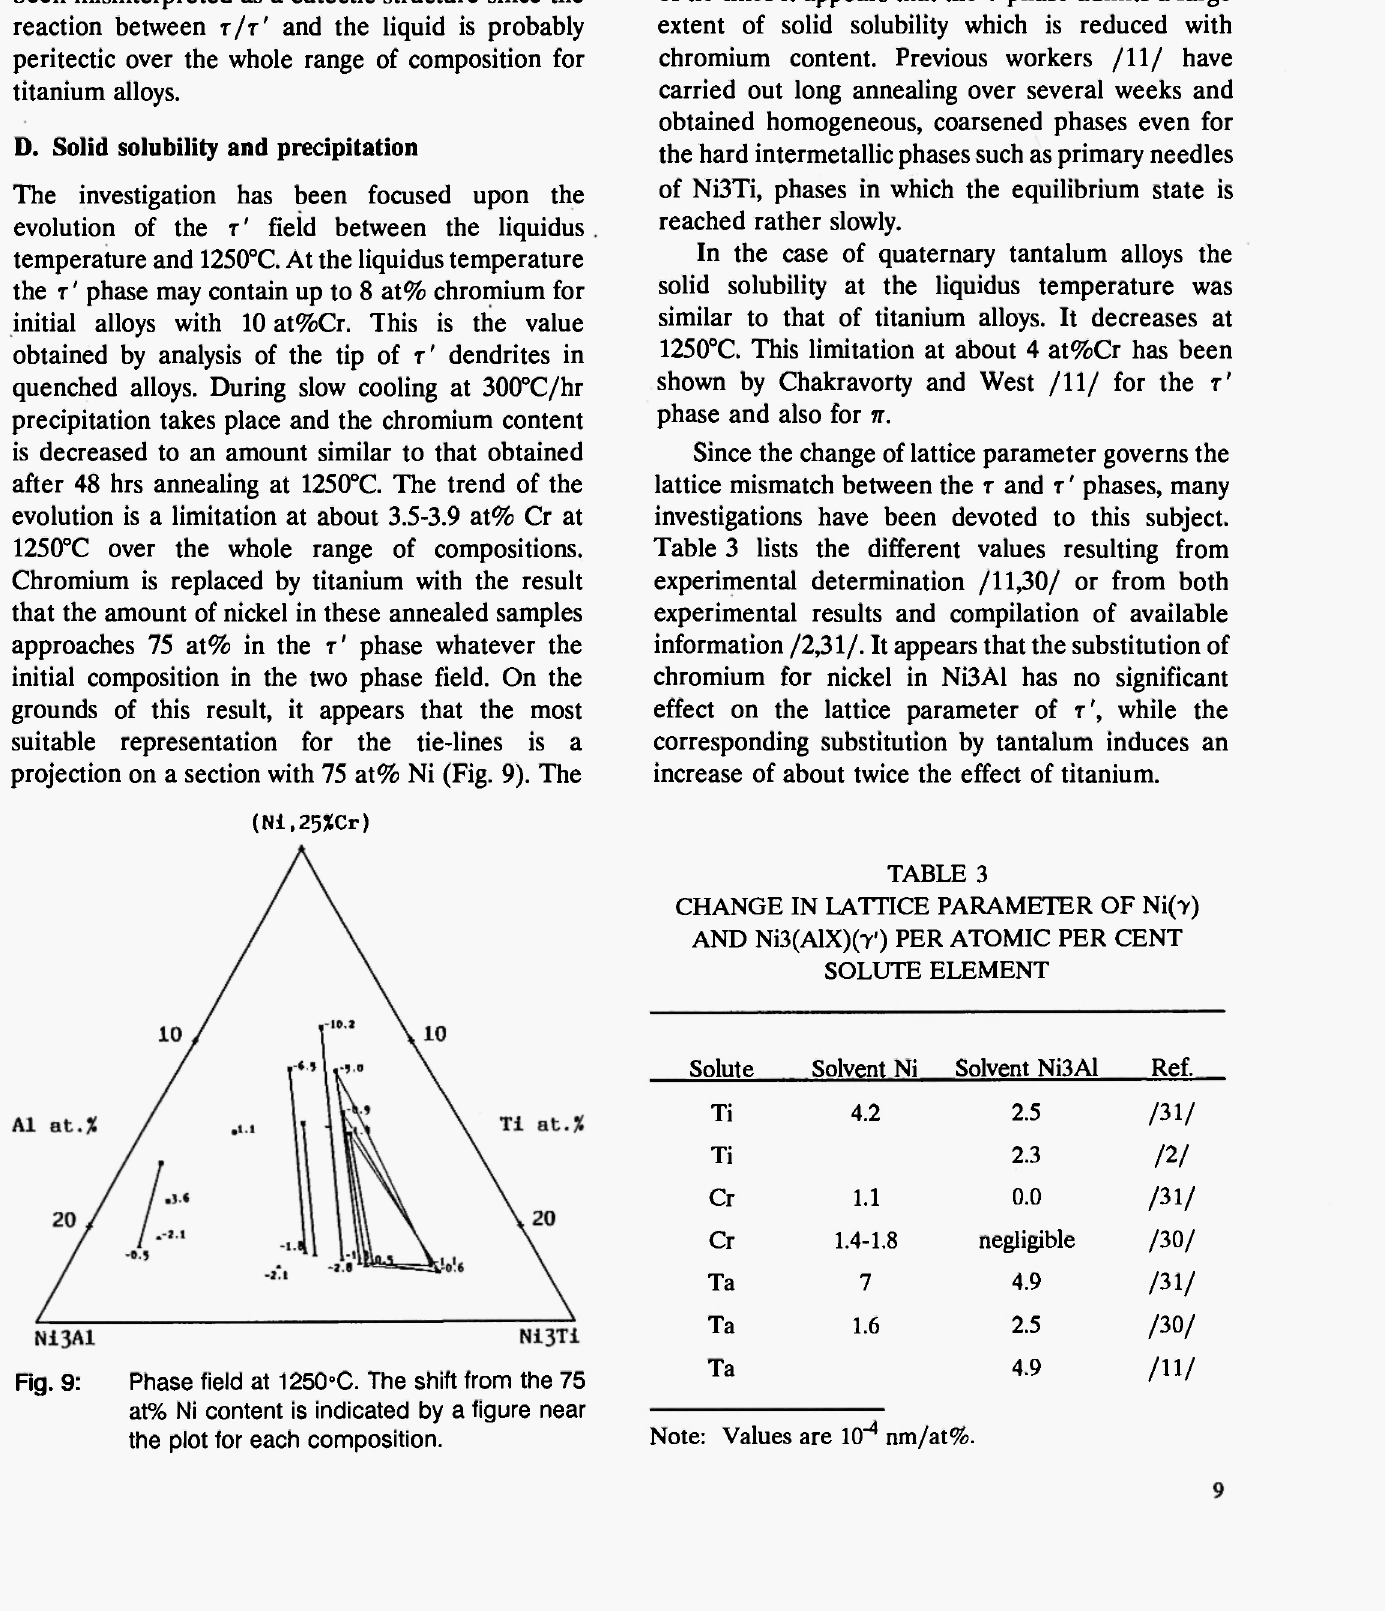
Fig. 9: Phase field at 1250°C. The shift from the 75 at% Ni content is indicated by a figure near the plot for each